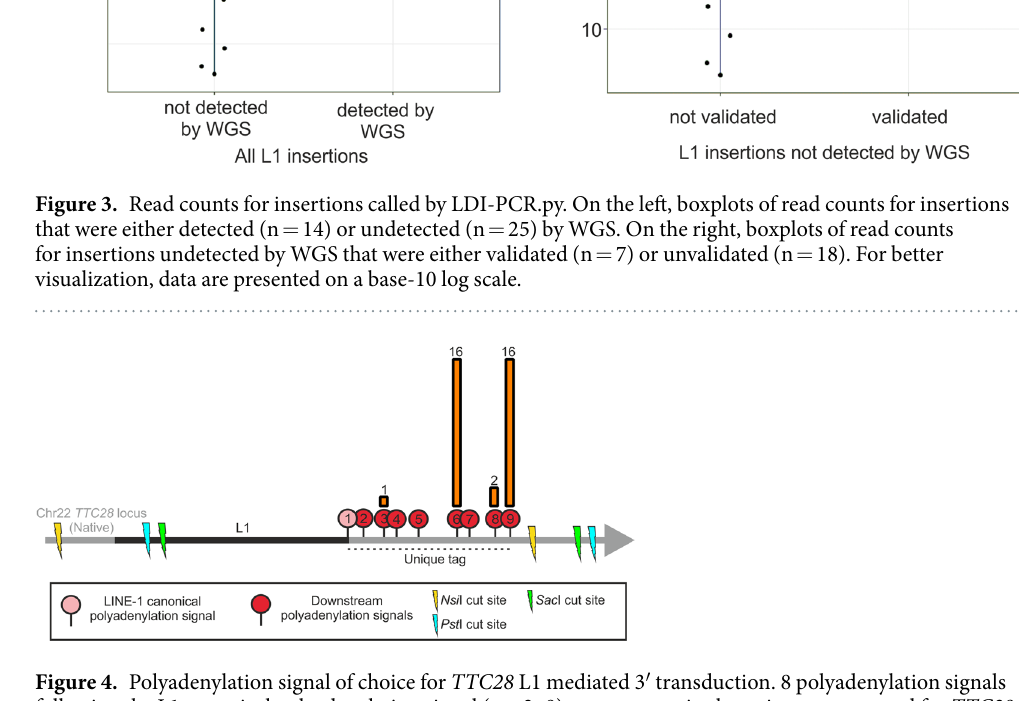
Figure 4. Polyadenylation signal of choice for TTC28 L1 mediated 3 ′ transduction. 8 polyadenylation signals following the L1 canonical polyadenylation signal (no. 2–9) were present in the unique tag assessed for TTC28 L1 3 ′ transduction. Most of the 3 ′ transductions identified in this study terminated utilizing the 6th and 9th polyadenylation signal instead of the L1’s canonical polyadenylation signal (no. 1). The height of the orange bars indicates the frequency of L1 3 ′ transductions terminating at each polyadenylation signal; number of termination events is given above the